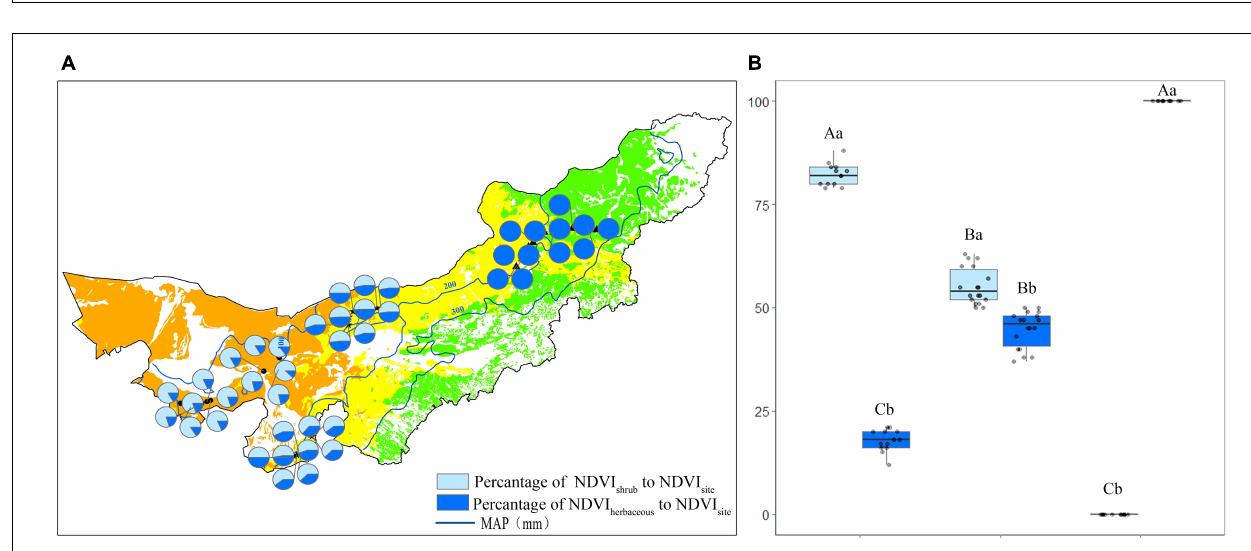
FIGURE 4 | Normalized difference vegetation index value for each observation site (A) , and statistics for desert, transition zone, typical steppe (B) in July and August. Different capital letters denoted significant differences of NDVI value among desert, transition zone, and typical steppe ( P < 0.05); while different lowercase letters denoted significant differences between July and August ( P < 0.05); the same letters denoted non-significant differences ( P > 0.05); MAP represents the mean annual precipitation. * denoted significant difference of normalized difference vegetation index value between the two observations of each site.